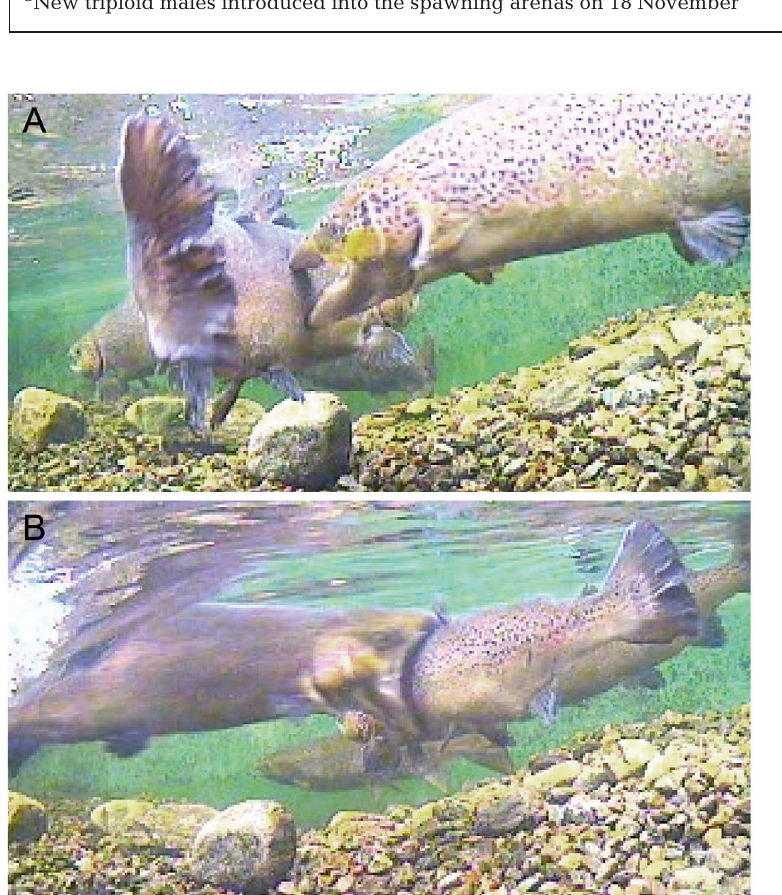
Fig. 1. Triploid male aggression (Arena 1). Triploid male (A) attacking and (B) biting laterally at the trunk region of another triploid male. The wild female can be spotted in the nest close to the wall of the arena in both A and